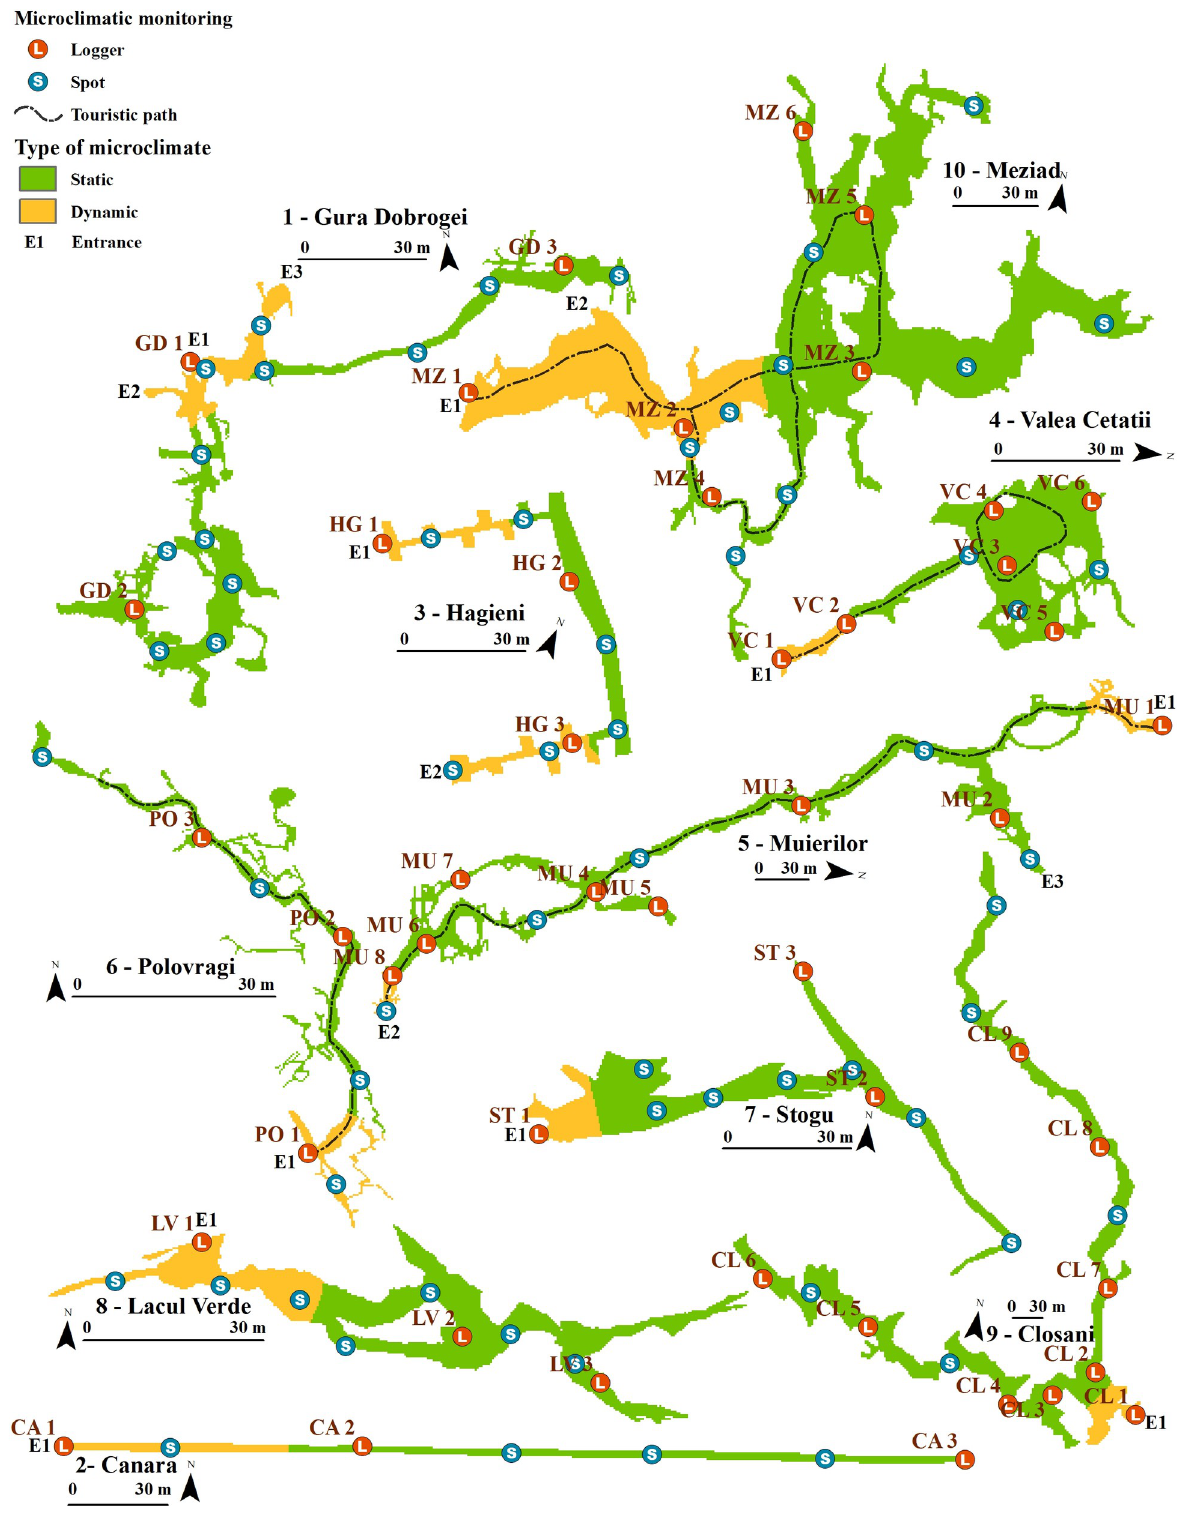
Fig 2. Map of the selected SEs, location of the air temperature monitoring stations or spot measurements, and a classification of the yearly air temperature ranges: Static climate = < 5˚C yearly variations, dynamic climate = > 5˚C yearly variations. Source of the georeferenced maps: Polovragi cave [59]; Clo ş ani cave [60]; Valea Cet ăţ ii cave [61]; Lacul Verde, and Stogu caves [62]; Meziad cave [63].